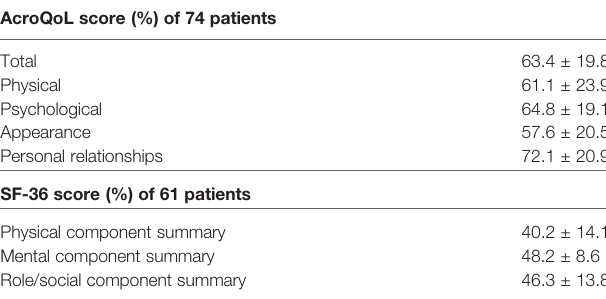
TABLE 1 | Baseline characteristics of all patients. TABLE 2 | QoL scores of 74